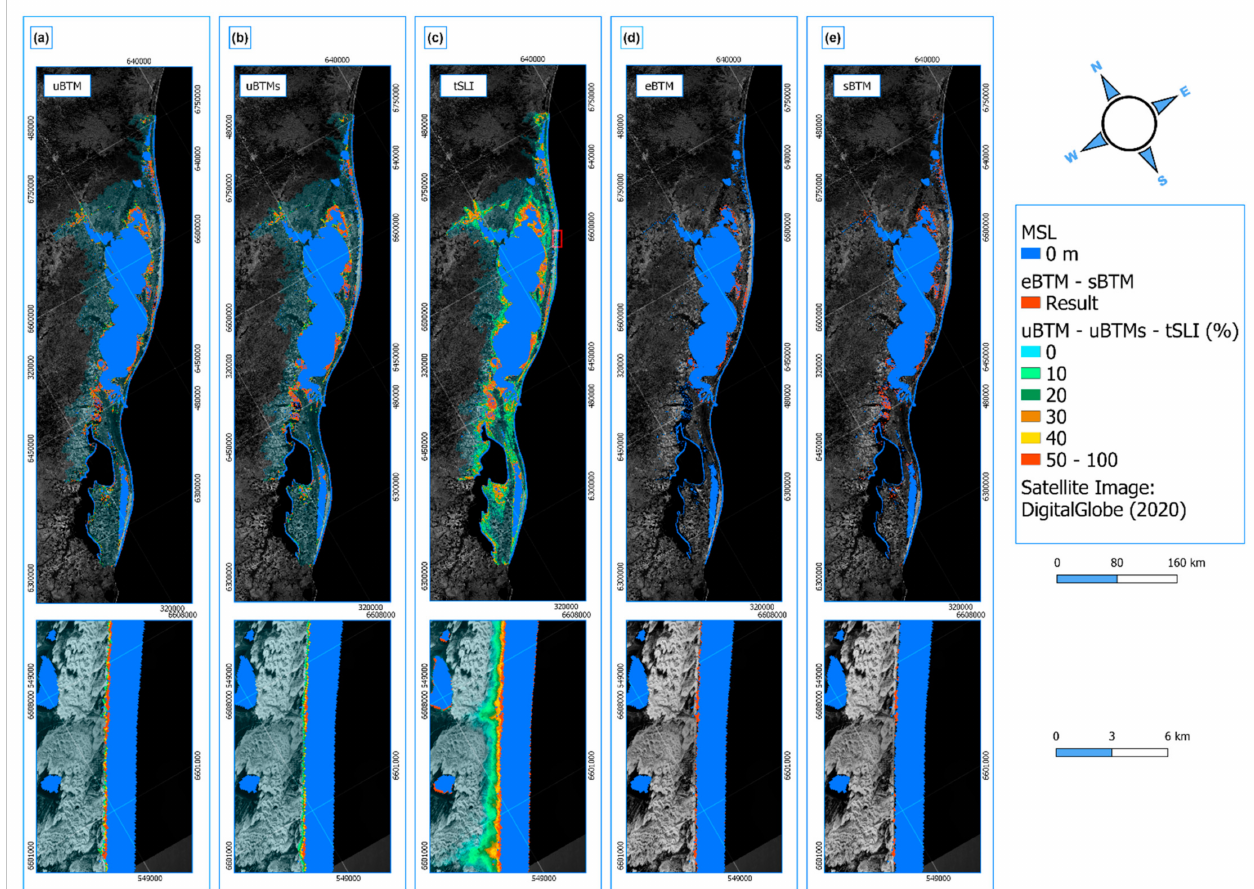
Figure 4. Rio Grande coastal plain impact results. ( a ) Uncertainty Bathtub model (uBTM). ( b ) Uncertainty Bathtub Model smoothed (uBTMs). ( c ) Terrset Sea-Level Impact (tSLI). ( d ) Enhanced Bathtub Model (eBTM) in red. ( e ) Simple Bathub Model (sBTM) in